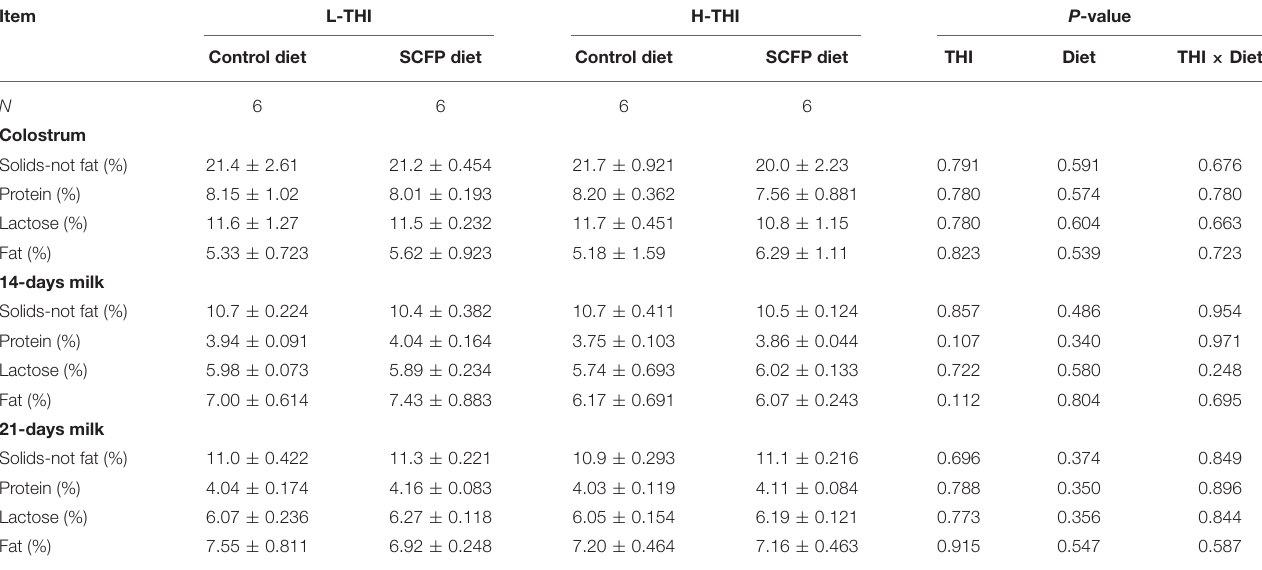
TABLE 5 | Effects of dietary supplementation of Saccharomyces cerevisiae fermentation product during late pregnancy and lactation on colostrum and milk composition of sows in a subtropical climate (Mean ± SE). Item